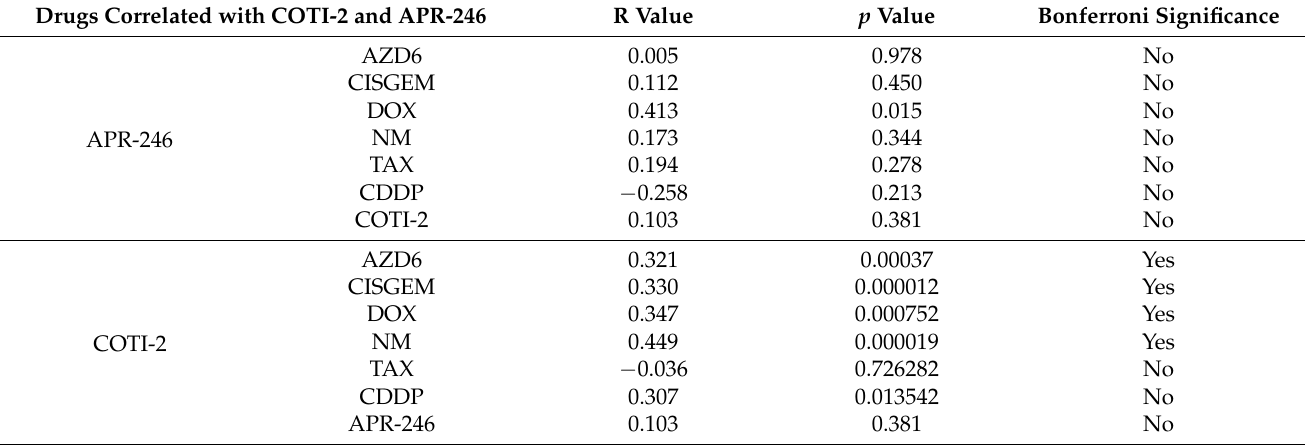
Table 1. Correlation Coefficients for COTI-2 and APR-246 Activity Against Other Drug